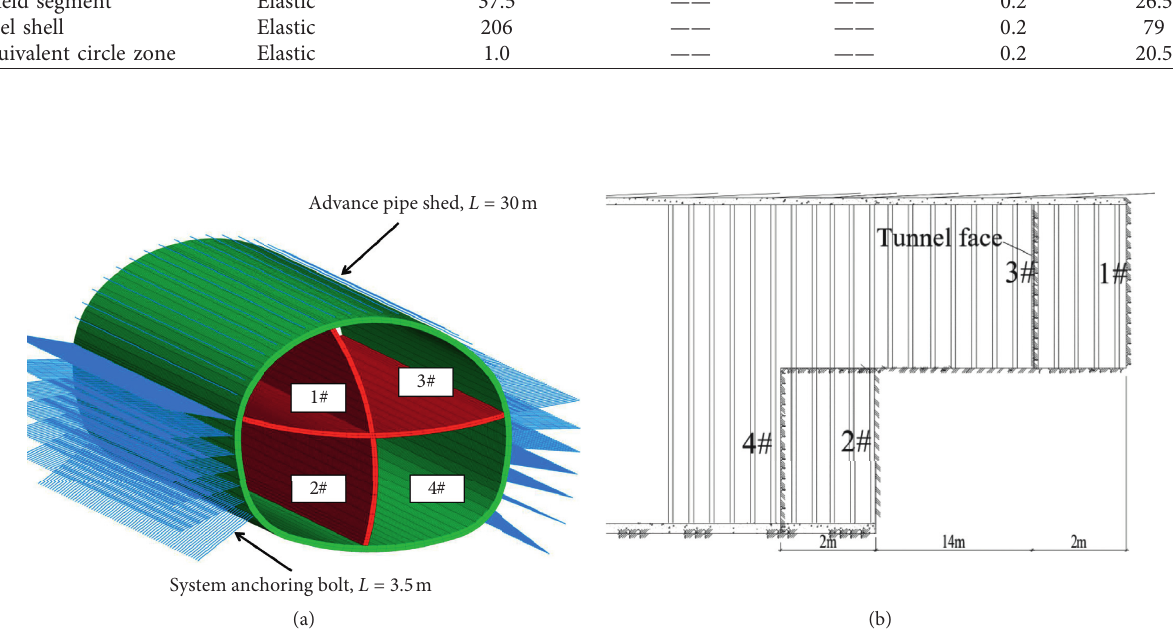
Figure 20: Mining method branch excavation simulation. (a) Mining tunnel excavation model; (b) sequence chart of longitudinal section of the mining